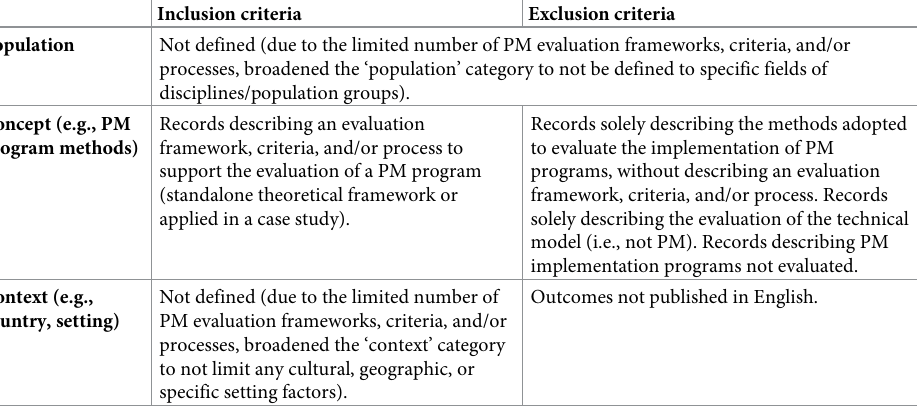
Table 2. Inclusion and exclusion criteria in a population, concept, context format, as recommended by